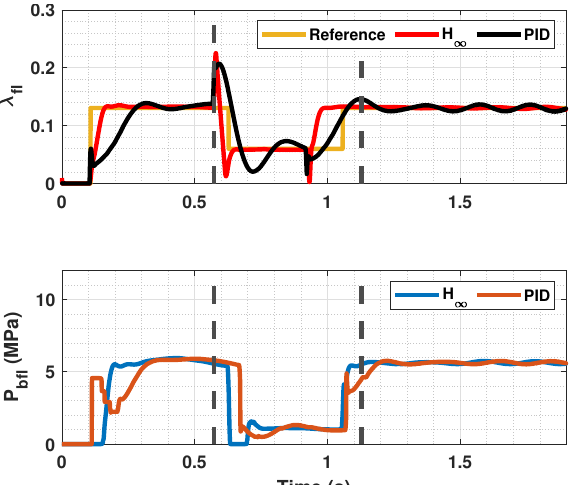
Figure 14. Front wheels tire slip, reference tire slip and brake pressure for changing µ max .